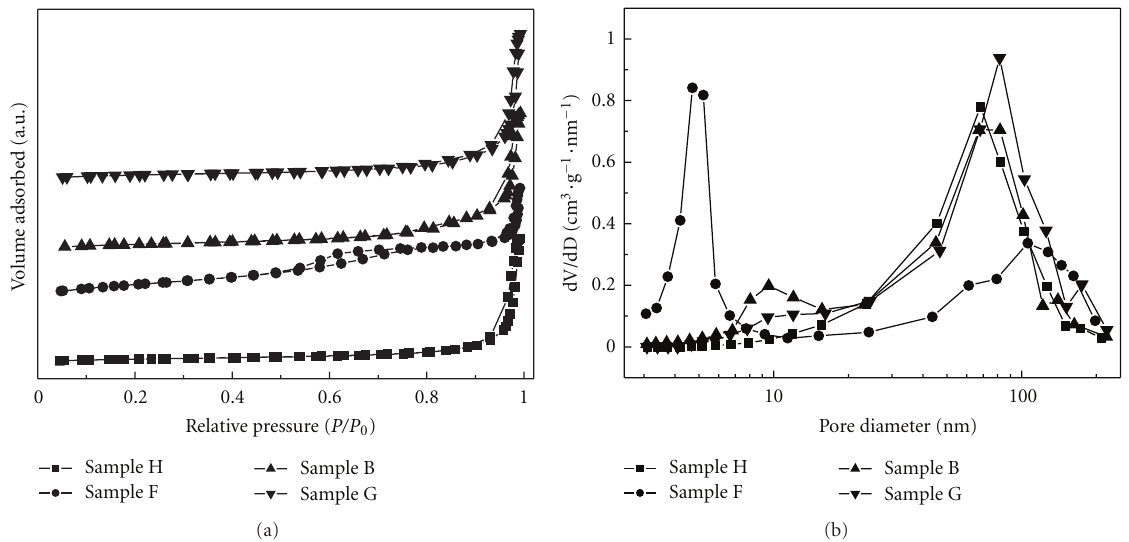
Figure 6: N 2 adsorption-desorption isotherm (a) of di ff erent samples at 77 K with corresponding pore size distributions (b) calculated by Barrett-Joyner-Halenda (BJH) method from desorption branch. All adsorption-desorption isotherm curves in (a) are added some units along the volume adsorbed axis ( Y axis) in order to observe clearly. ( (cid:2) ) Sample H, ( • ) Sample F, ( (cid:3) ) Sample B, and ( (cid:4) ) Sample G.